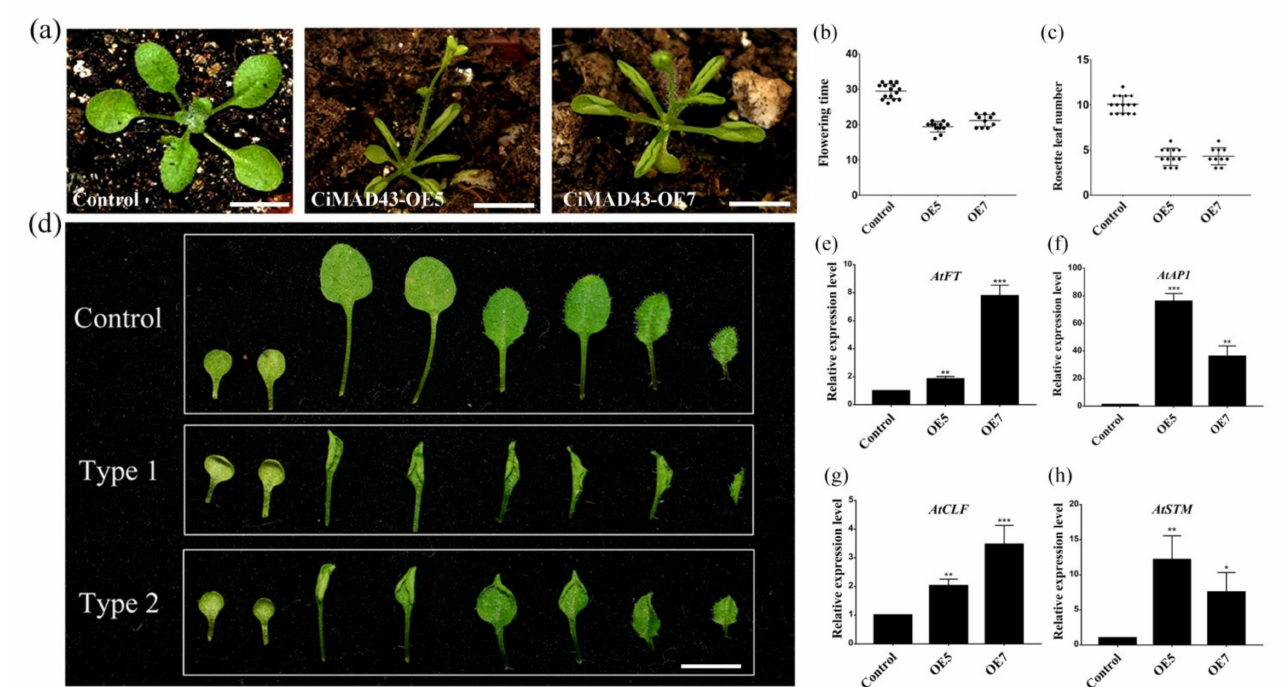
Figure 2. Ectopic expression of CiMADS43 caused early flowering and leaf curling in transgenic Arabidopsis . ( a ) CiMADS43 transgenic Arabidopsis significantly earlier flowering than the control. Two transgenic lines (CiMADS43-OE5 and CiMADS43- OE7) were selected as representatives of 12 transgenic lines for evaluating MADS43 function. ( b ) Statistical analysis of the flowering days of the CiMADS43 transgenic Arabidopsis . ( c ) Statistical analysis of the number of rosette leaves when the CiMADS43 transgenic Arabidopsis and the control begin to flowering. ( d ) Two types of curling rosette leaf from CiMADS43 transgenic Arabidopsis . Type 1: all rosette leaves except cotyledons severely curly. Type 2: only some rosette leaves slightly curly. Arranged from left to right according to different stages of leaf development, with the cotyledons on the far left. ( e , f ) Quantitative real-time polymerase chain reaction (qRT-PCR) analysis of Arabidopsis flowering-related genes ( AtFT and AtAP1 ) in the CiMADS43 transgenic Arabidopsis. ( g , h ) qRT-PCR analysis of Arabidopsis leaf development related genes ( CLF and STM ). Scale bar = 0.5 cm. Statistically significant is marked with asterisk(s) (* p < 0.05; ** p < 0.01; and *** p < 0.001; Student’s t